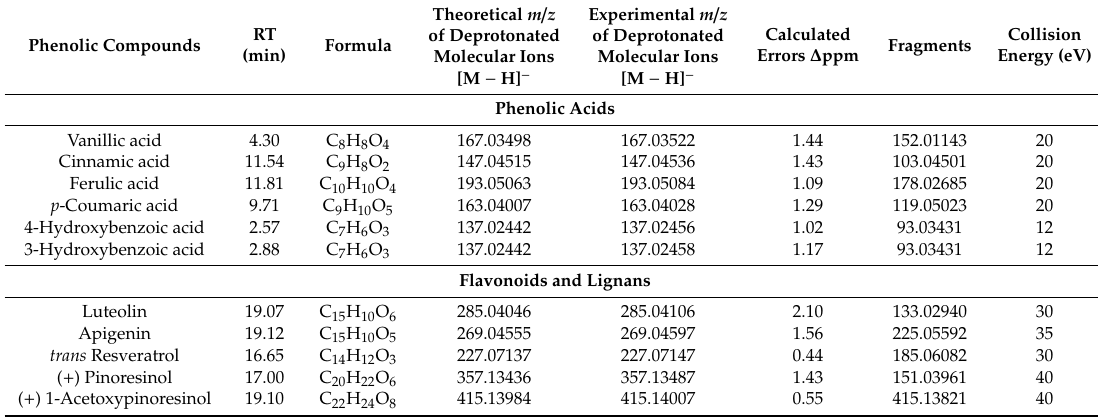
Table 2. Parameters used to characterize the phenolic